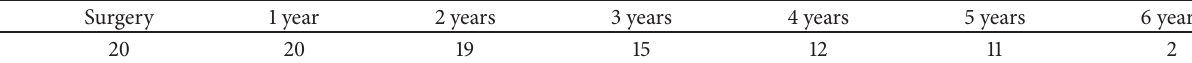
Table 1: Postoperative follow-up of 20 patients ( n : number of patients).